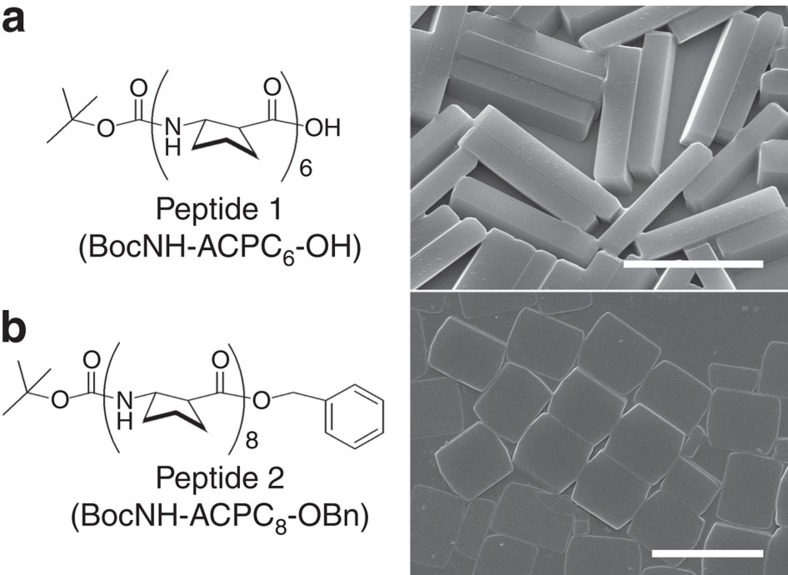
β-Peptide building blocks and SEM images of corresponding foldectures.(a) Peptide 1 (BocNH-ACPC6-OH) and SEM image of rhombic rod foldectures (F1). (b) Peptide 2 (BocNH-ACPC8-OBn) and SEM image of rectangular plate foldectures (F2). Scale bars, 5 μm. Boc, tert-butyloxycarbonyl.